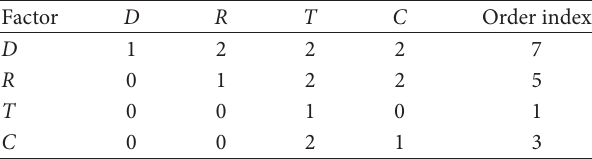
Table 4: Pairwise comparison matrix of 𝑈 2 based on 0–2 scale.